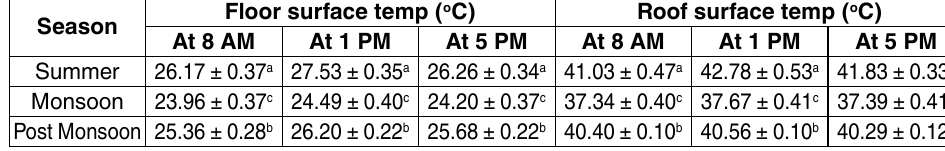
table 2. Mean daily heat generated from floor and roof during different seasons